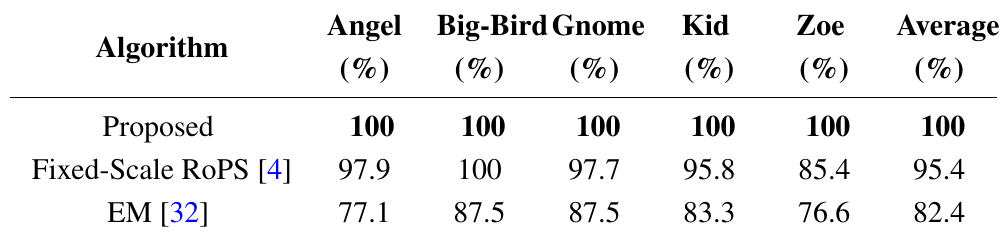
Table 2. Recognition rates on the full Queen’s dataset. The best results are in bold